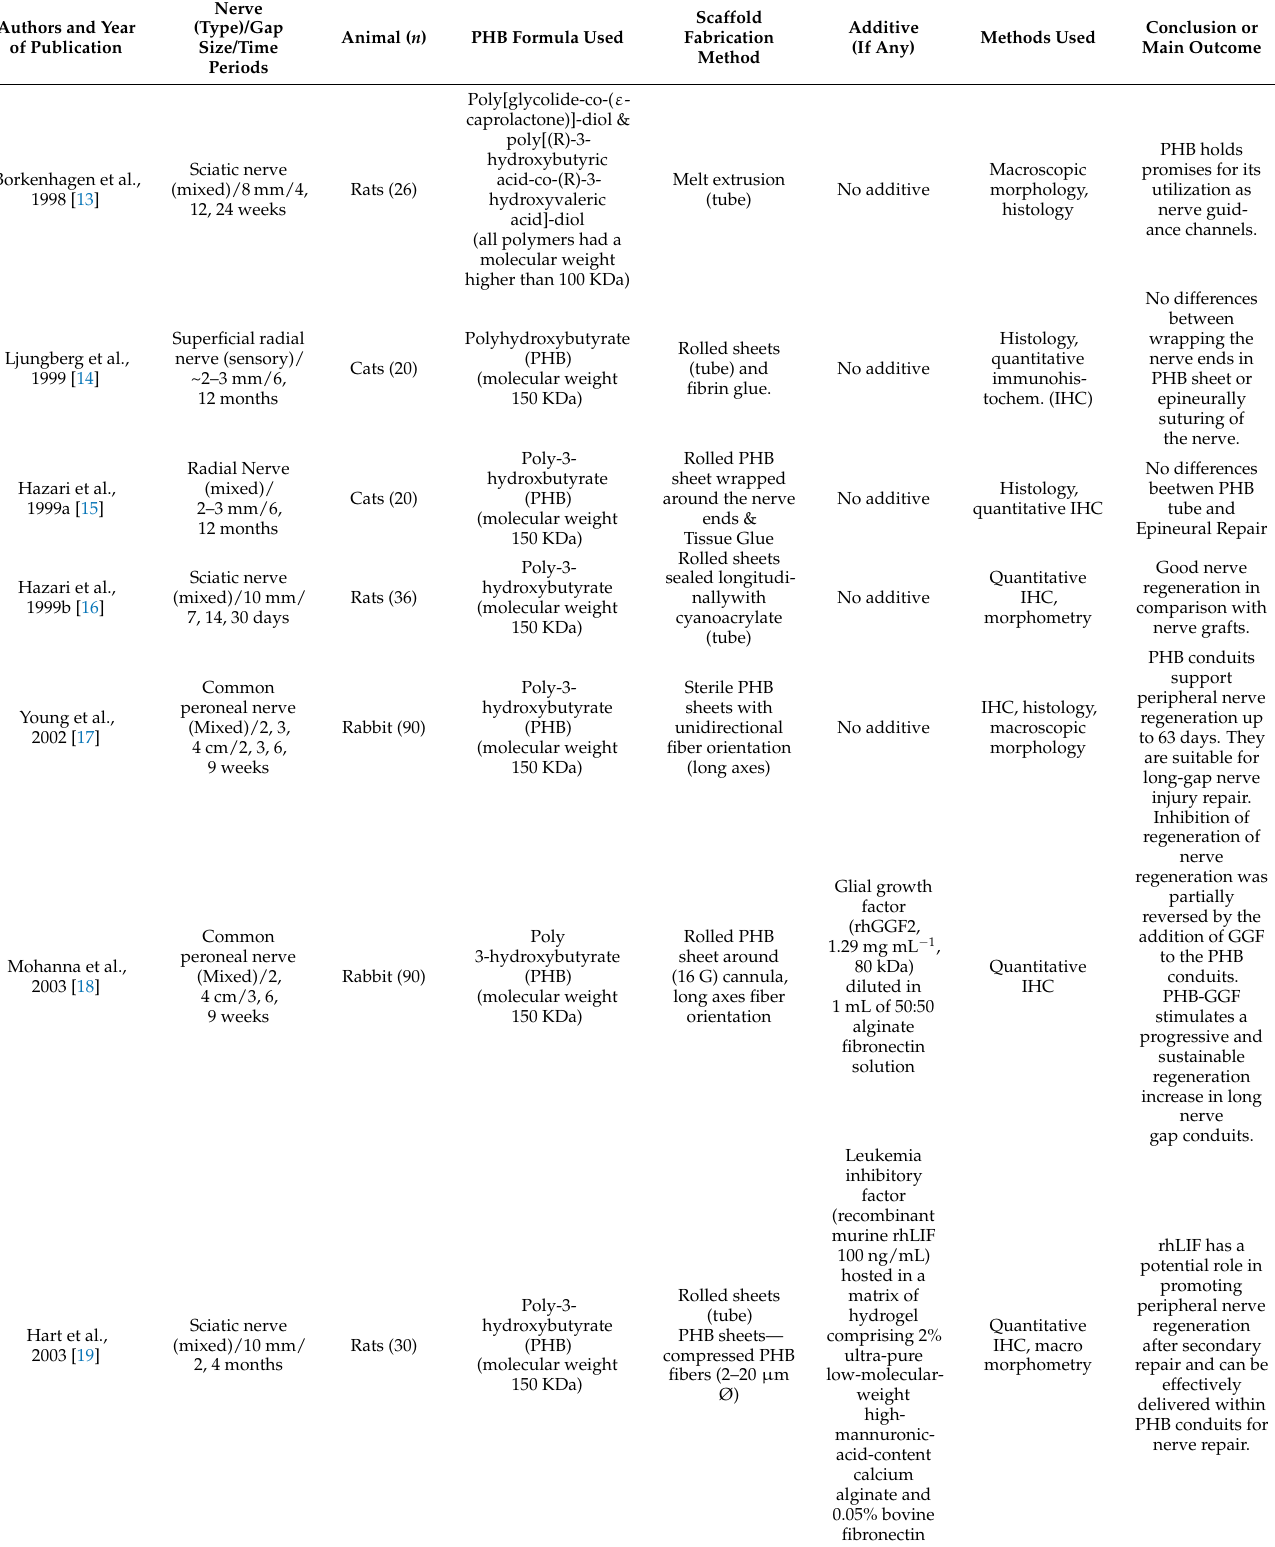
Table 1. Evidence extracted from animal studies